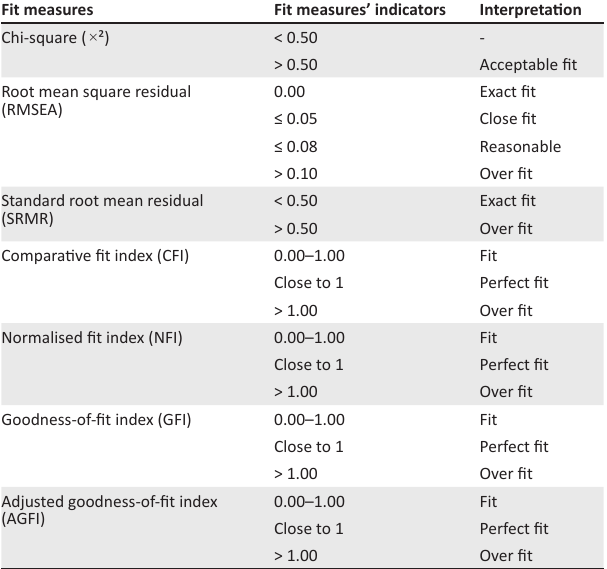
TABLE 7: Model fit measures’